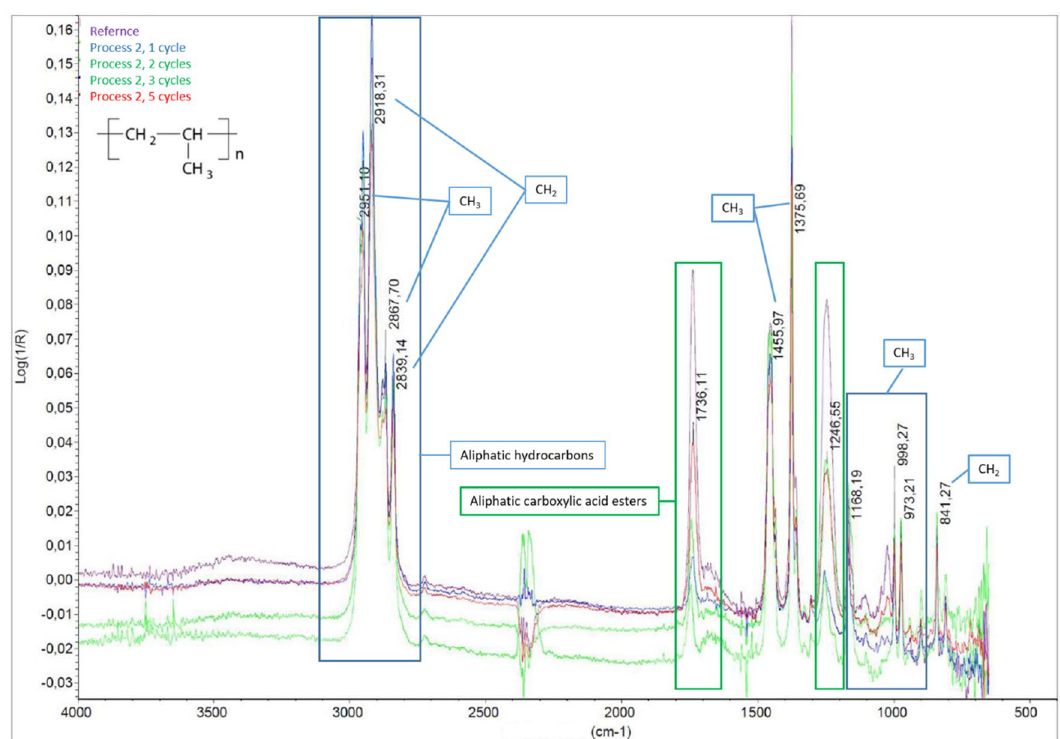
Fig. 7 ATR spectra for polypropylene as a function of the number of process